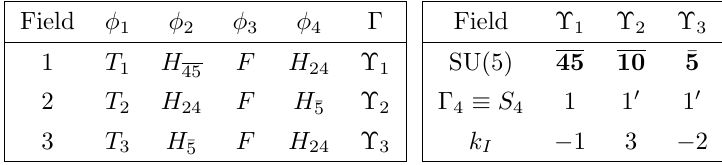
Table 3 . Left panel: the dimension 5 operators corresponding to (cid:12)gure 2, Right panel: the charges of messenger (cid:12)elds appear in the dimension 5